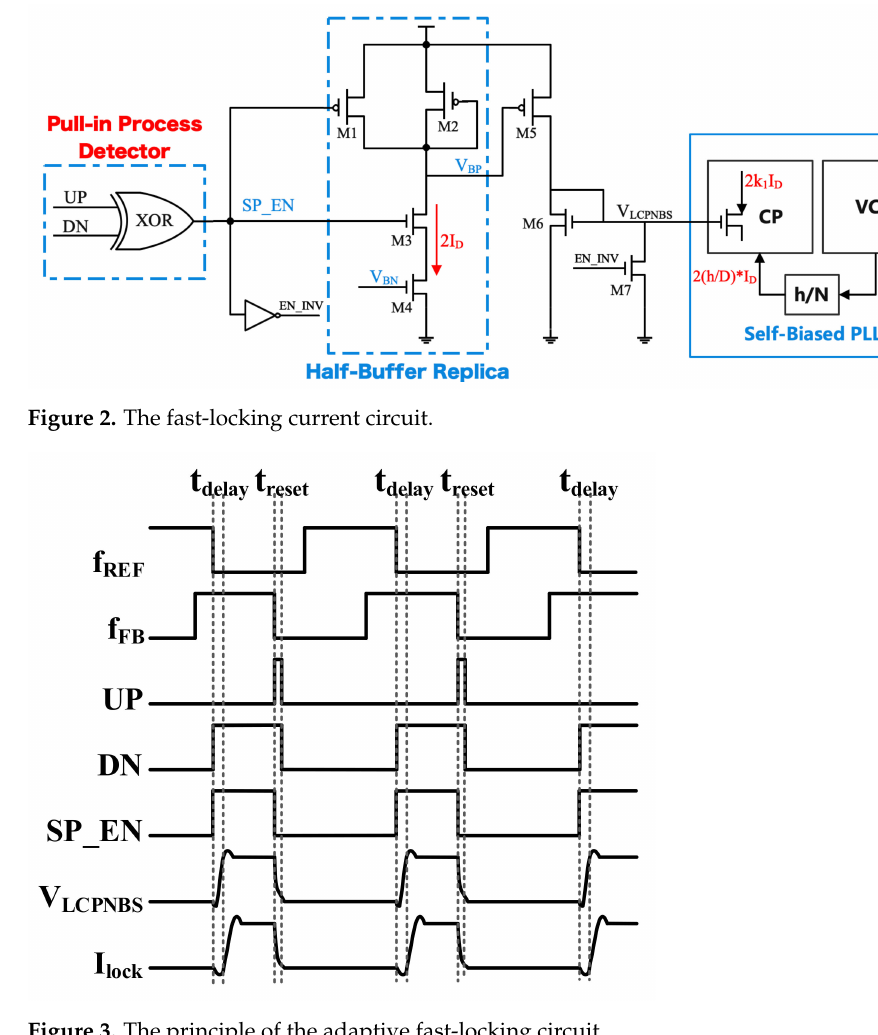
Figure 3. The principle of the adaptive fast-locking